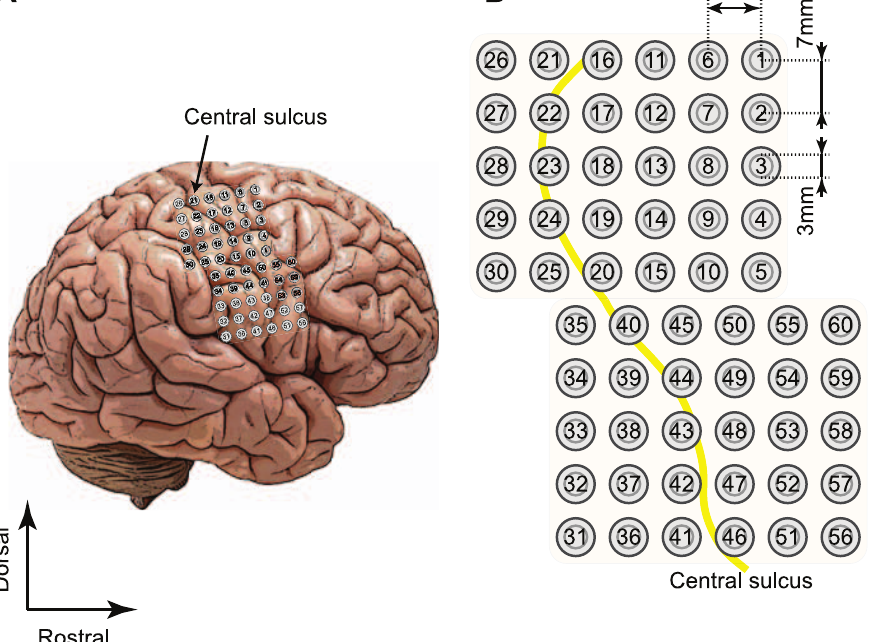
Figure 2. Electrodes placed on the sensorimotor cortex of patient 1. (A) Positions of the electrodes (circles). (B) Two 5 6 6 electrode arrays were placed on the right hemisphere, covering the sensorimotor cortex. Yellow lines depict the right central sulcus.